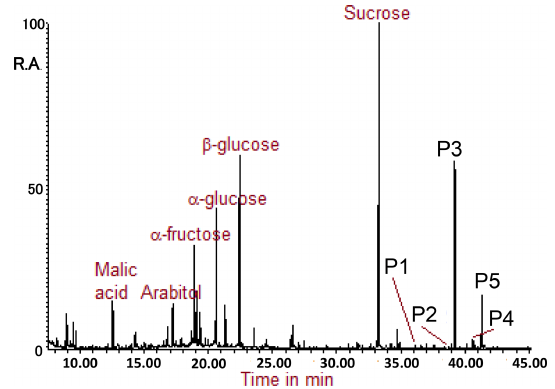
Figure 2. GC-MS total ion chromatogram obtained for the TMS derivatives. P1–P5 refer to peaks, which correspond to the sec- ondary fatty alcohols identified in this